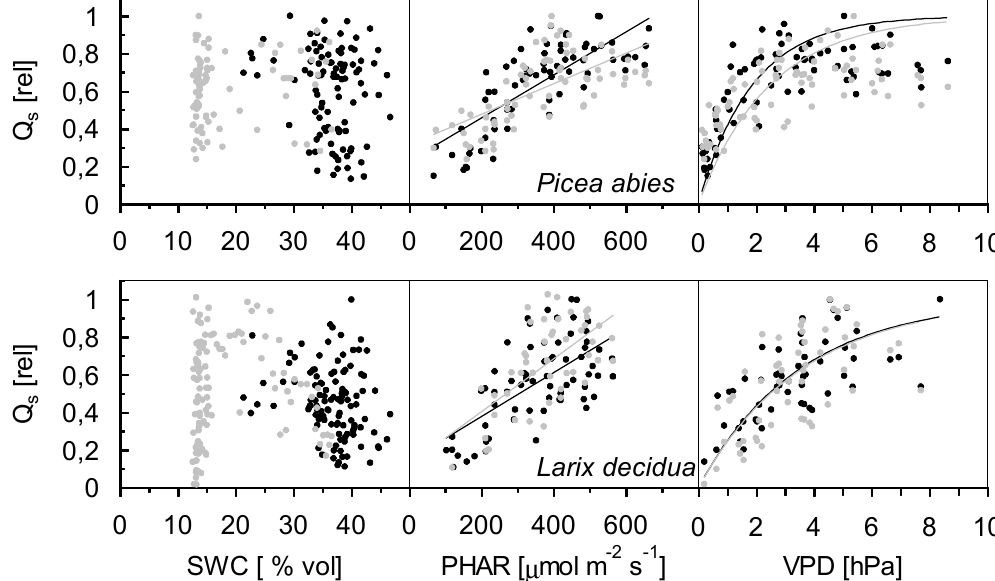
Figure 3. Daily mean normalized sap flow density ( Q s ) of Picea abies and Larix decidua saplings in the control (black) and the rain exclusion treatment (grey) in relation to soil water content at a 5–10 cm soil depth (SWC, left ), photosynthetic active radiation (PHAR, middle ), and vapor pressure deficit (VPD, right ) obtained in 2017. Points are mean values of three saplings per treatment. Points were fit by linear and exponential saturation functions for PHAR and VPD, respectively. Picea abies : PHAR: control: y = 0.001 × PHAR + 0.23, R 2 = 0.61; rain exclusion: y = 0.0008 × PHAR + 0.32, R 2 = 0.42; VPD: control: y = 1 × (1 − exp ( − 0.54 × VPD)), R 2 = 0.69; rain exclusion: y = 1*(1 − exp( − 0.39 × VPD)), R 2 = 0.54. Larix decidua : PHAR: control: y = 0.001 × PHAR + 0.14, R 2 = 0.41; rain exclusion: y = 0.002 × PHAR + 0.09, R 2 = 0.41; VPD: control: y = 1 × (1 − exp( − 0.28 × VPD)), R 2 = 0.48; rain exclusion: y = 1 × (1 − exp( − 0.28 × VPD)), R 2 = 0.46. All P < 0.001.